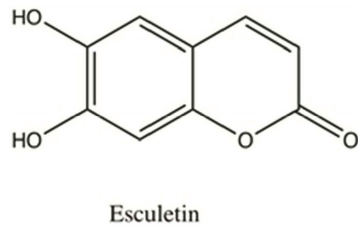
FIGURE 1 - Chemical structure of